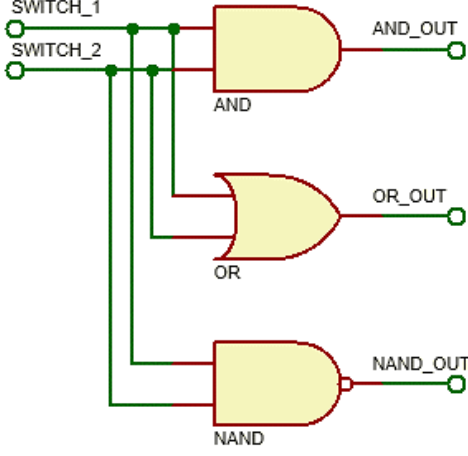
Figure 13. Basic logic gates circuit configuration.